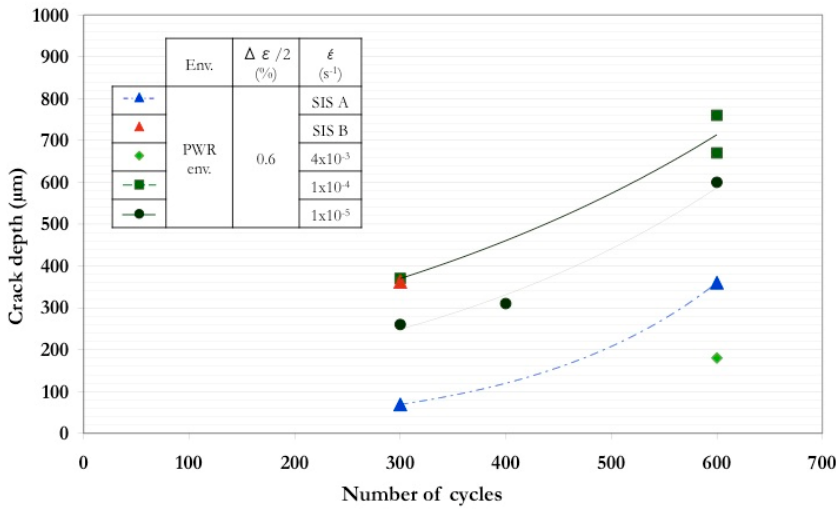
Figure 11. Comparison of the measured crack depths during interrupted tests for different loading conditions.